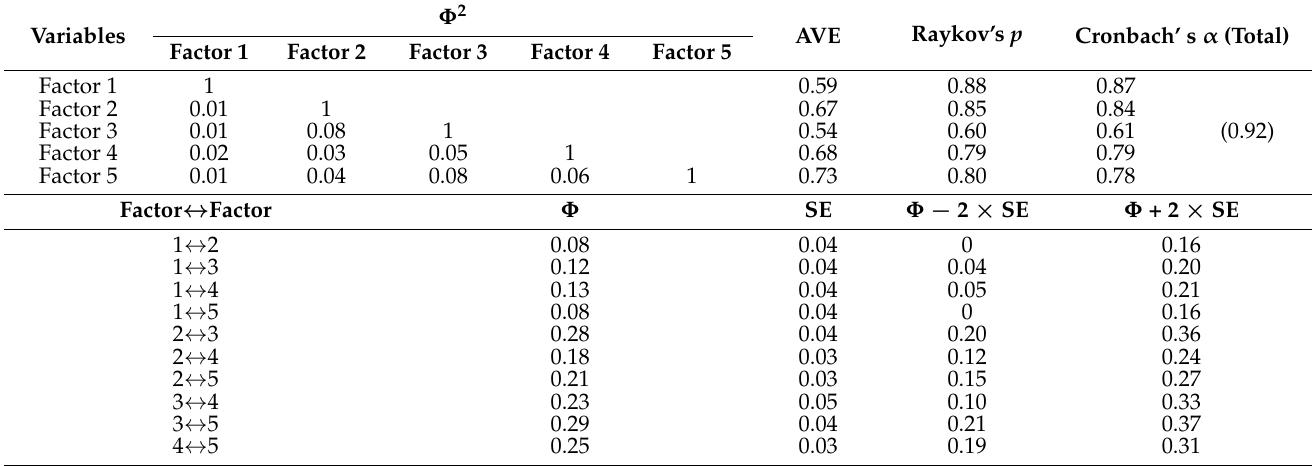
Table 6. Discriminant validity of average variance extracted and 95% confidence interval in confirmatory factor